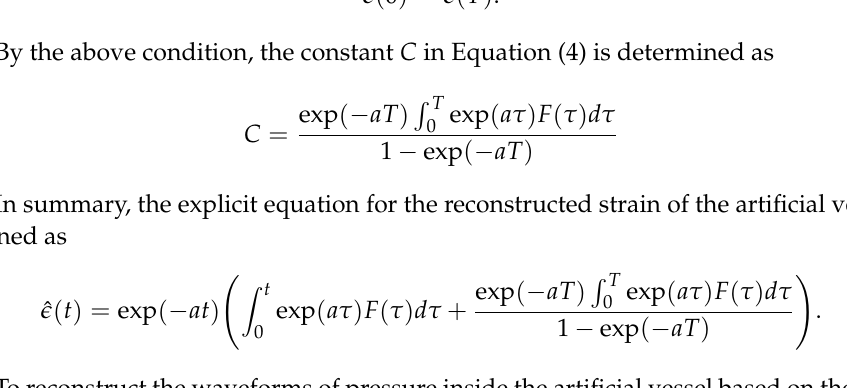
Figure 7. Results of the optimization study ( a ) Change of objective function, 𝑂𝑏𝑗 (cid:3006) 𝐸 (cid:2870) and 𝜂 (left), whose value is minimized when 𝐸 (cid:2870) = 71.32 MPa and 𝜂 = 39.94 MPa s , ( b ) The comparison between the reconstructed strain and deformation.